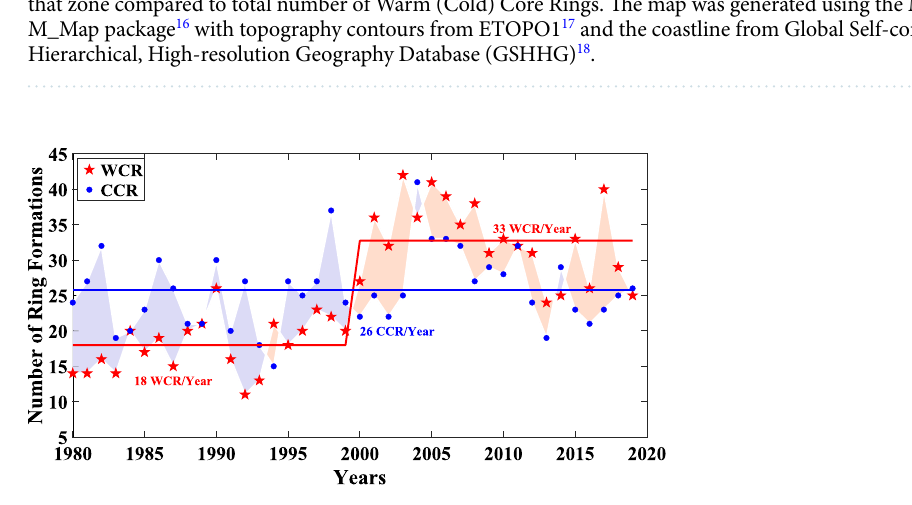
Figure 2. Interannual variability of the Warm Core Ring and Cold Core Ring formation between 1980 and 2019. The regime shift (denoted by the split in the red solid line) for the Warm Core Rings is significant at the turn of the century. Note the phase change from “More Cold Core Rings—Fewer Warm Core Rings” to “More Warm Core Rings—Fewer Cold Core Rings” after the year 2000. The average formation rates for different time- periods are indicated within the